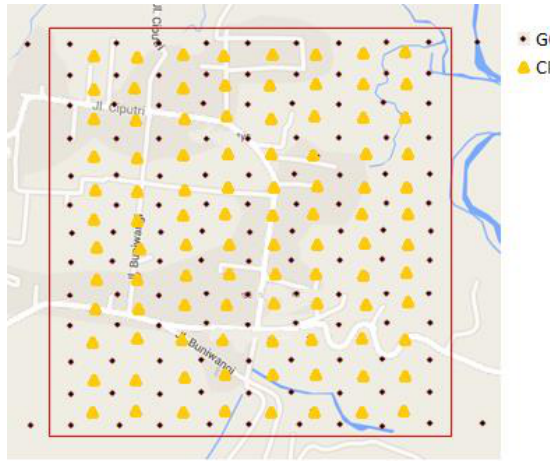
Figure 4 Control point